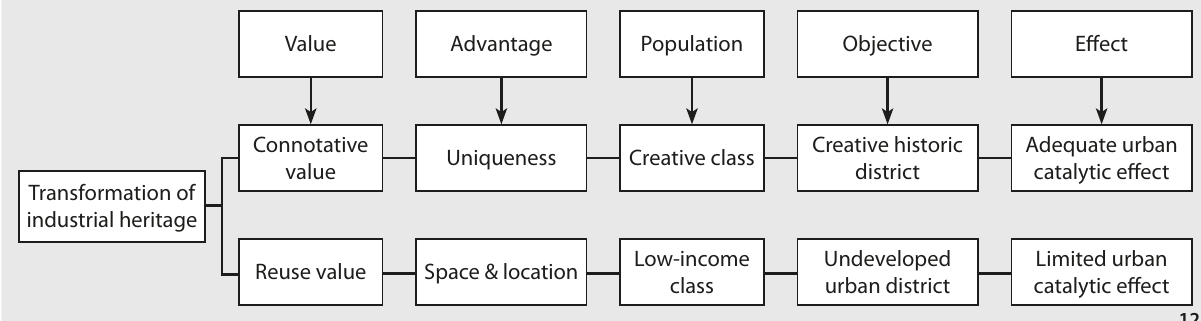
Figure 12 Two diverse routes of transformation of industrial heritage (Source: the